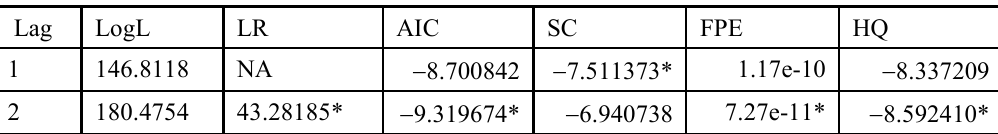
Table 5 . Optimally Selected Akaike Criteria of